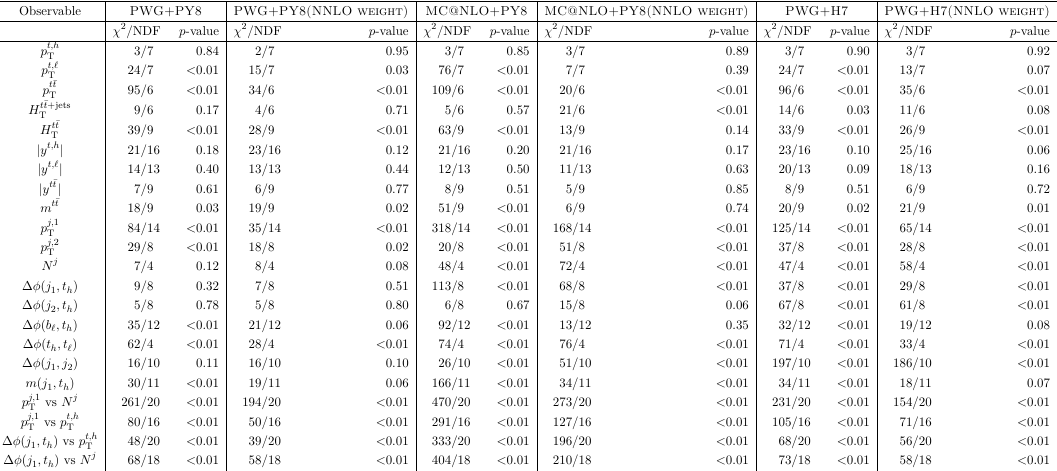
Table 6. χ 2 and p -values quantifying the level of agreement between the relative unfolded spec- tra, several NLO+PS predictions and the respective NNLO reweighted spectrum. PWG+PY8 corresponds to the Powheg+Pythia sample, PWG+H7 to the Powheg+Herwig sample and MC@NLO+PY8 to the MadGraph5_aMC@NLO+Pythia